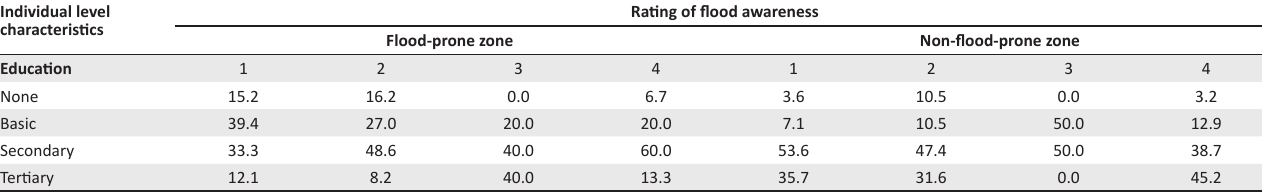
TABLE 3: Relationship between level of education and flood disaster awareness. Individual level characteristics